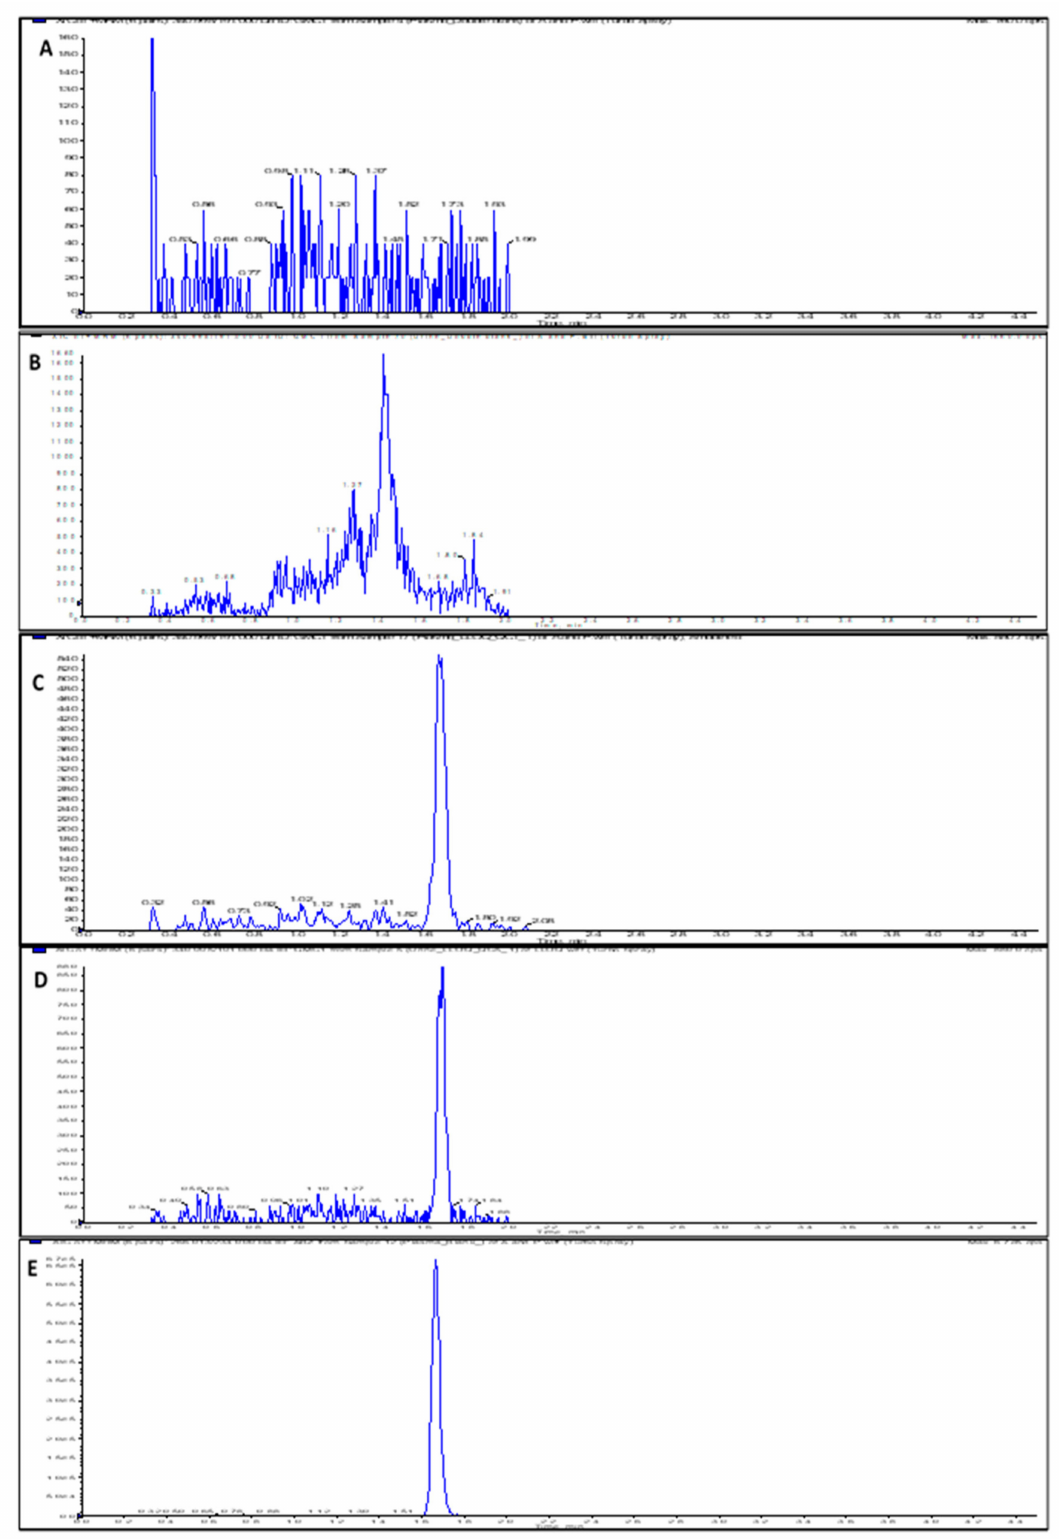
Figure 2. LC-MS / MS chromatograms (XIC of multiple reaction monitoring (MRM)) for ( A ) Double blank rat plasma sample; ( B ) Double blank rat urine sample; ( C ) Rat plasma sample spiked with LLOQ concentration (1 ng / mL) of GMC1; ( D ) Rat urine sample spiked with LLOQ concentration (1 ng / mL) of GMC1; ( E ) Blank rat plasma sample showing spiked